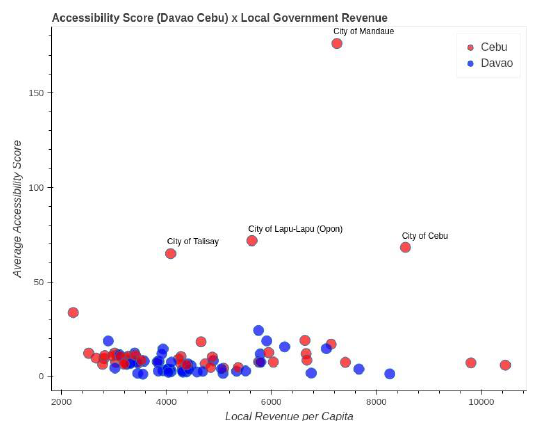
Figure 7 : Revenue per capita and Accessibility in the Cebu and Davao